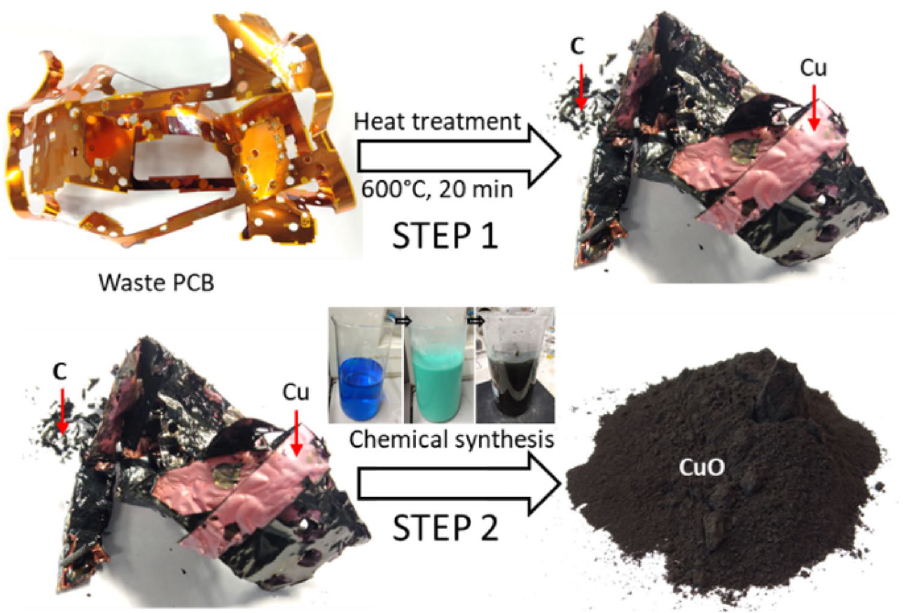
Figure 1. Steps for the synthesis of NiO-doped CuO